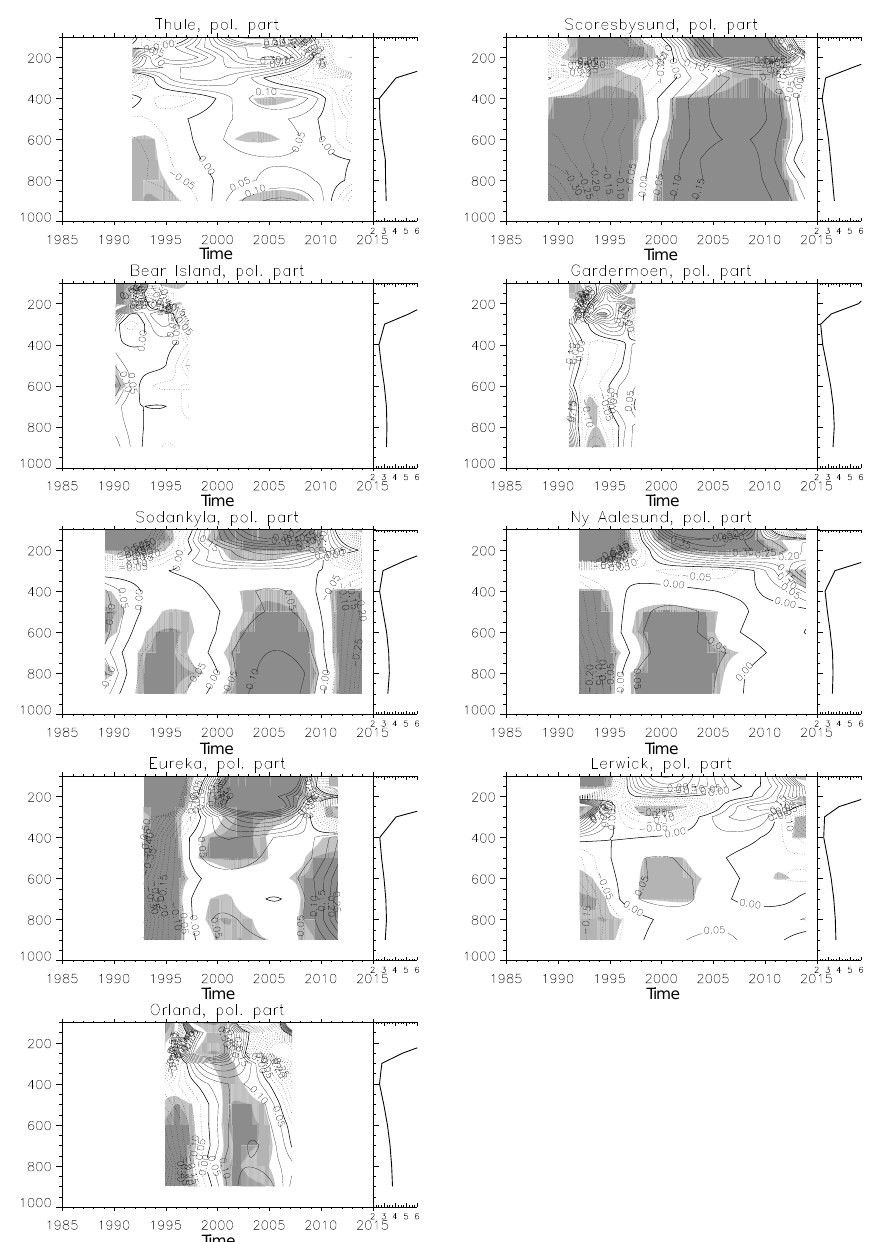
Figure 7. The polynomial part of the model as a function of time and pressure. The temporal means are shown in the panel to the right as a function of height. The contours show the anomalies with respect to this mean. Shaded regions are where the anomalies are statistically different from the temporal means at 99 and 95% levels. Model settings: n pol = 4, n cyc = 2, n 1 tr = n θ tr = 0 and white